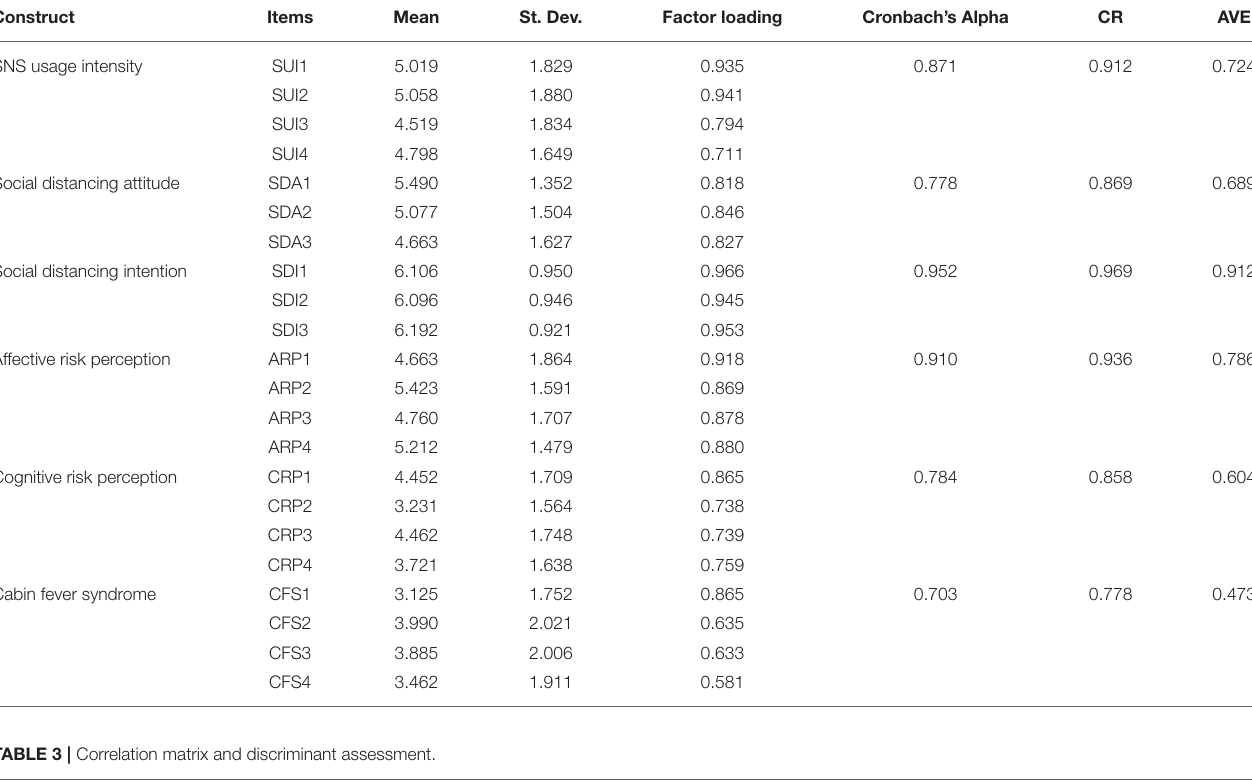
TABLE 2 | Scale reliabilities.